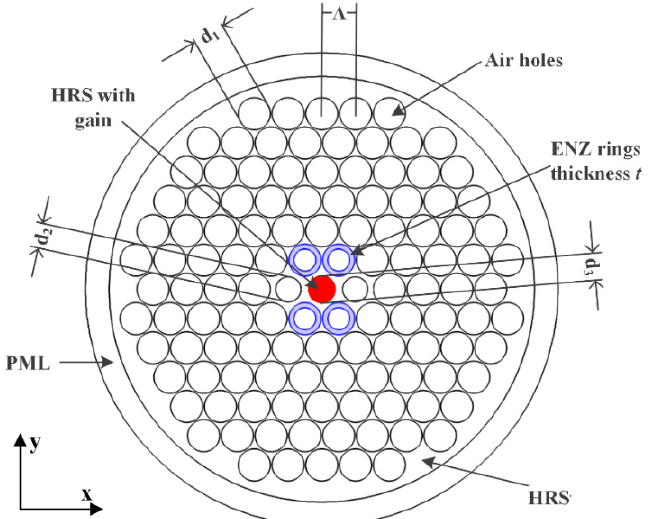
Figure 1. Cross sectional view of the proposed terahertz (THz) single-polarization-single-mode (SPSM) photonic crystal fiber (PCF). ENZ, epsilon-near-zero; PML, perfectly matched layer; HRS, high resistivity silicon.